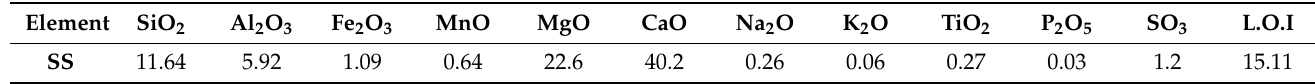
Table 3. Chemical composition of steel slag by XRF